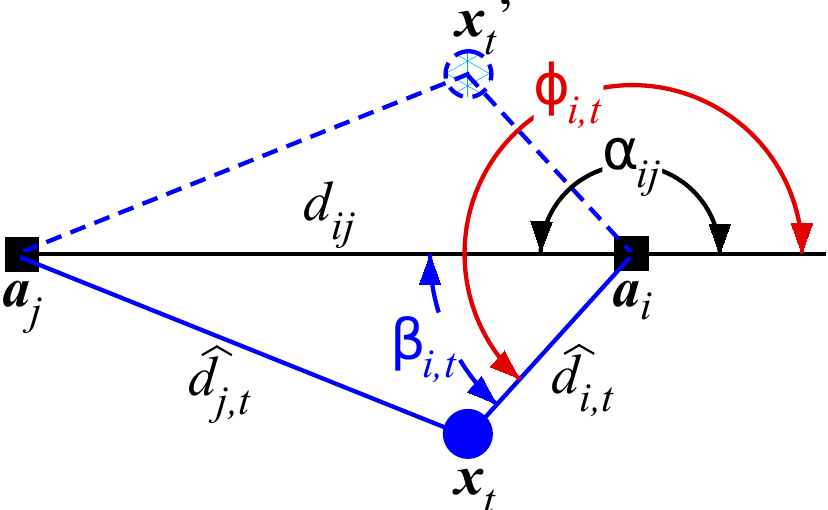
Figure 1. Geometrical interpretation of the AOA estimation